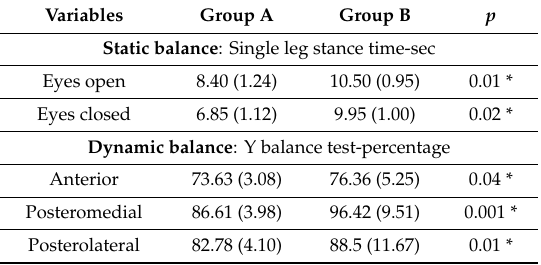
Table 3. Comparison of static and dynamic balance between the groups: Mean